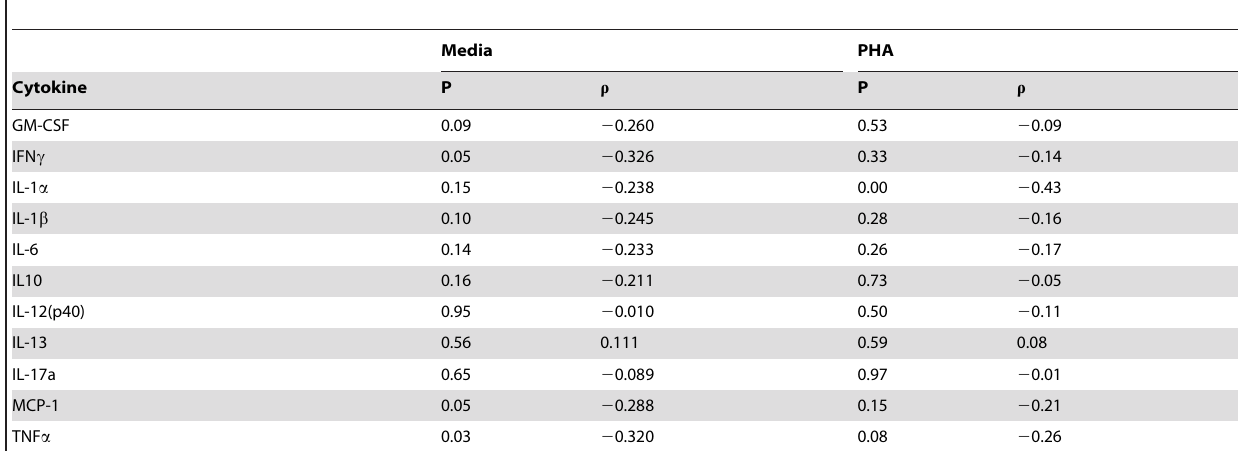
Table 2. CGG Repeat length vs. Cytokine production from human